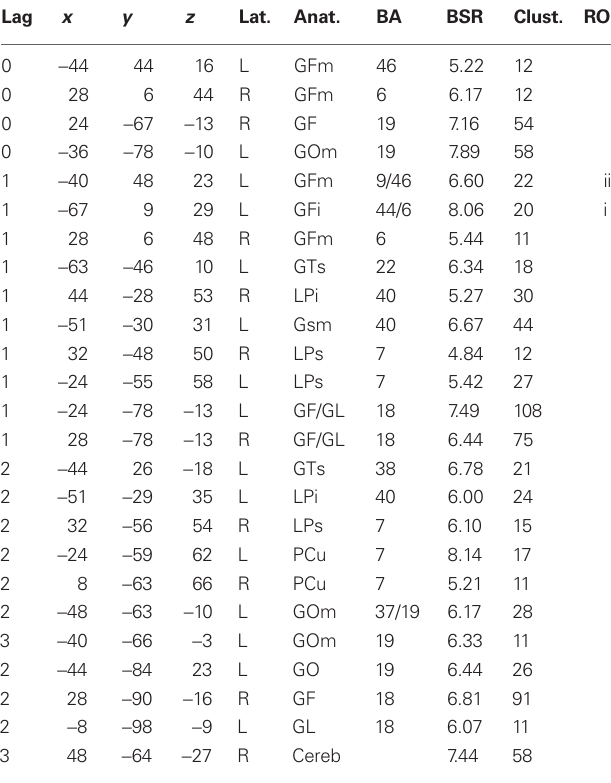
These regions demonstrated a positive correlation with task accuracy. Cluster threshold (BSR) was > 4, corresponding approximately to p < 0.0001, with minimum size of 10 voxels. All column headings and abbreviations as in Table 1. ROI, region of interest (roman numerals correspond to regions highlighted in Figure 2